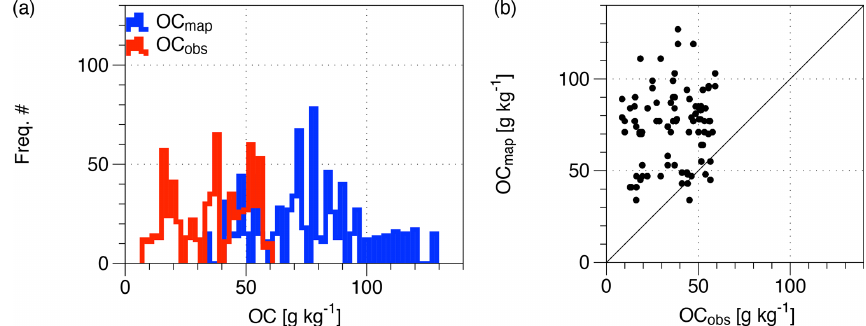
Figure 3. Comparison between organic carbon (OC) observation from SMAPVEX12 (red) and data sampled from the highly resolved SoilGrid250m map (Hengl et al., 2017) (blue) (a) in histogram and (b) in scatter plot. Table 2. A , B , and C parameters of the relationship between the effective dielectric constant and soil moisture adapted from Park et al. (2017) with damping factor H (0.8); dielectric constant for free ( ε free ), bound water ( ε bound ), and soil mineral, including organic matter ( ε soil ). w